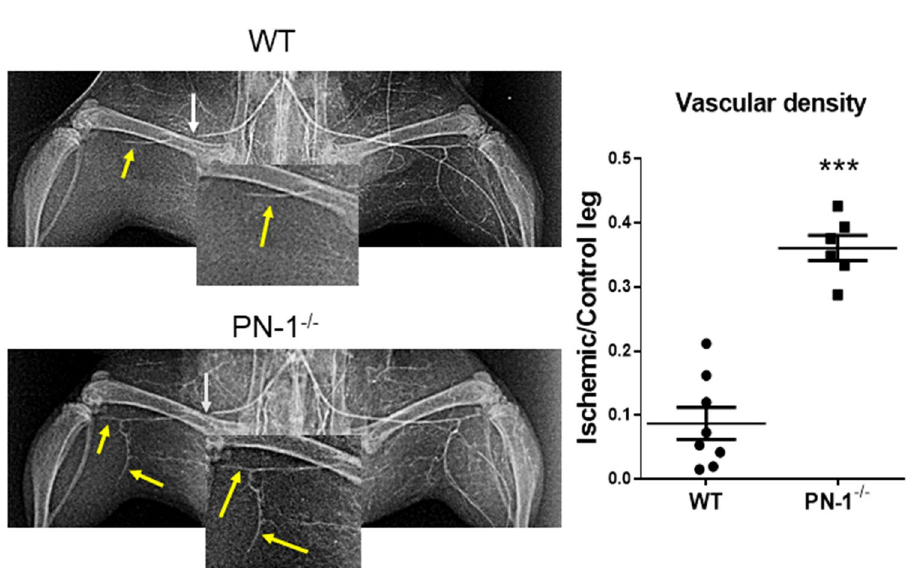
Figure 2. Representative photomicrographs and quantitative evaluation of microangiography. White arrows indicate the ligation, yellow arrows the reperfused vessels. Vascular density was determined by measuring the number of pixels occupied by vessels. t test *** p <